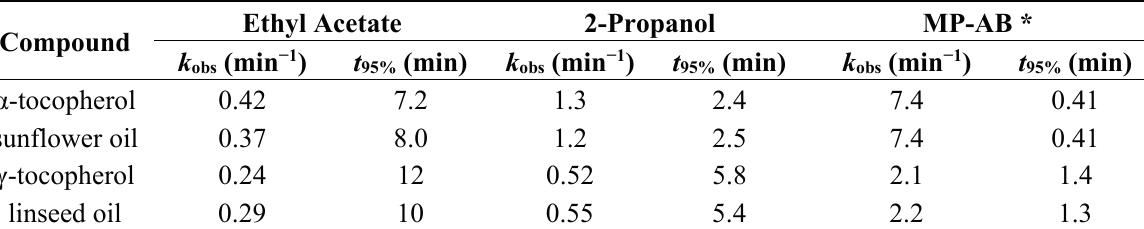
Table 1. Pseudo-first order rate constants and time needed to complete 95% of the first phase of the oxidation reactions of α -tocopherol, γ -tocopherol, and antioxidants in sunflower oil and linseed oil with DPPH determined in alcohols and ethyl acetate at 25 °C. Values are the average of three determinations and the standard deviation was ca.